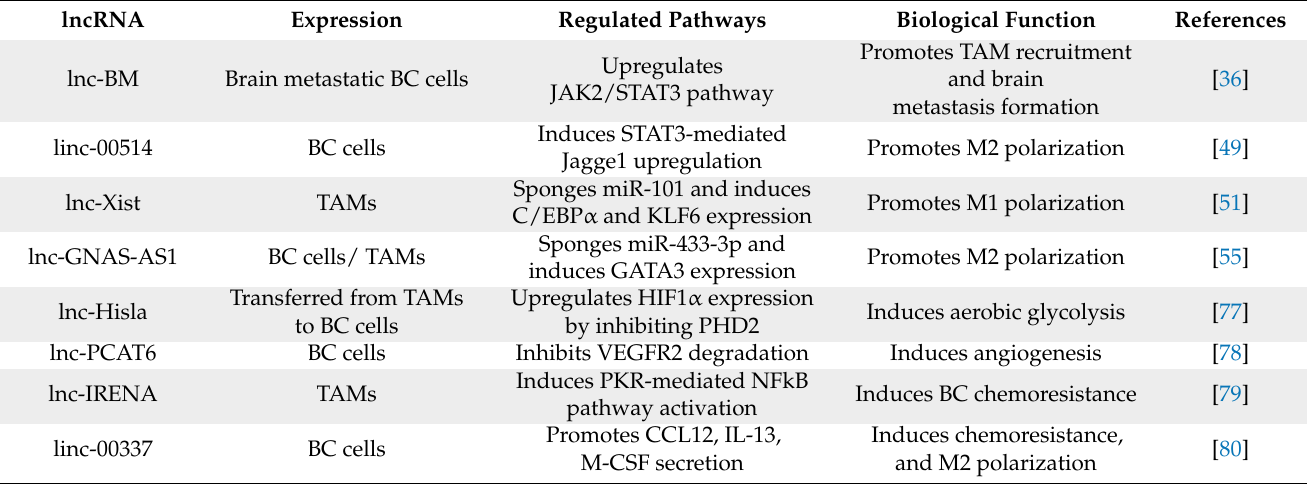
Table 2. lncRNAs involved in BC cells-TAM crosstalk during BC